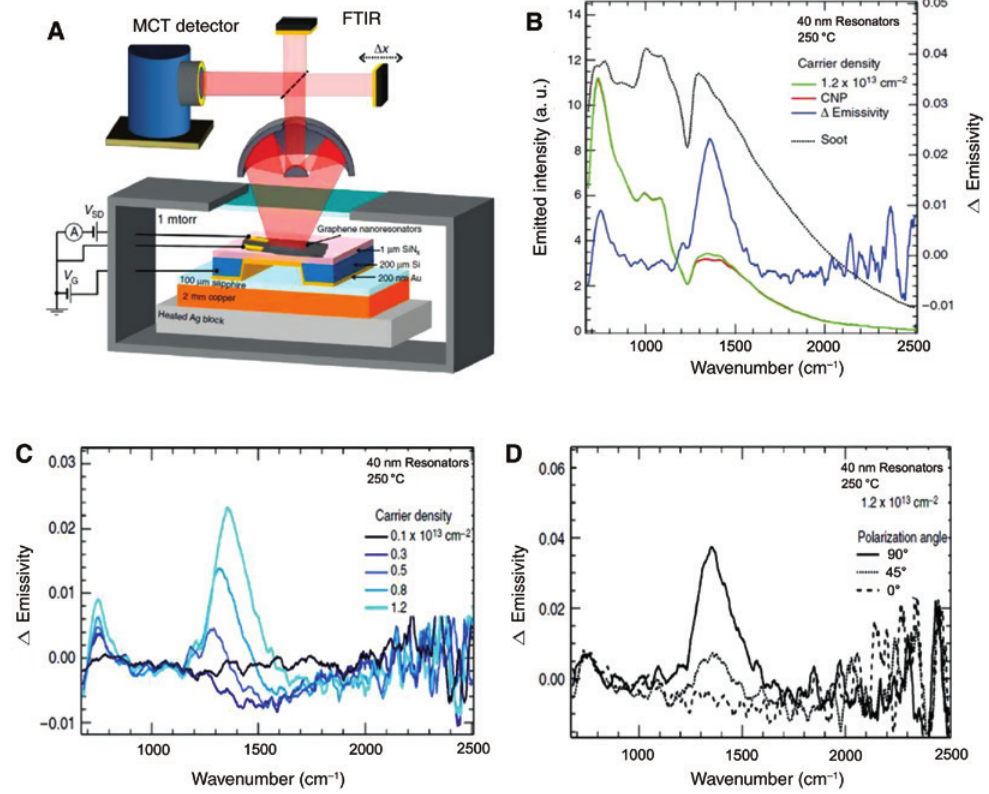
Figure 5: Plasmonic thermal emission in graphene. (A) Experimental set-up for the thermal emission studies. (B) Thermal emission spectra of a ribbon array at 250 ° C at charge neutral and heavily doped regimes. (C) Doping dependence of the emissivity enhancement spectrum. (D) Polarization dependence of the emissivity enhancement spectrum. (A–D) Reproduced with permission from [63]. © Copyright 2015 Nature Publishing